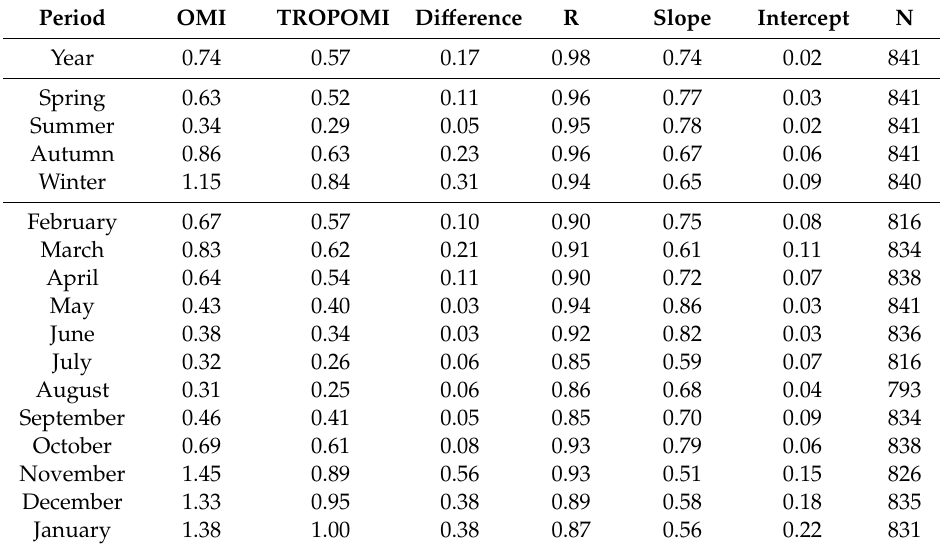
Table 1. Statistics describing the comparison of TROPOMI and OMI NO 2 retrievals over the Jing-Jin-Ji